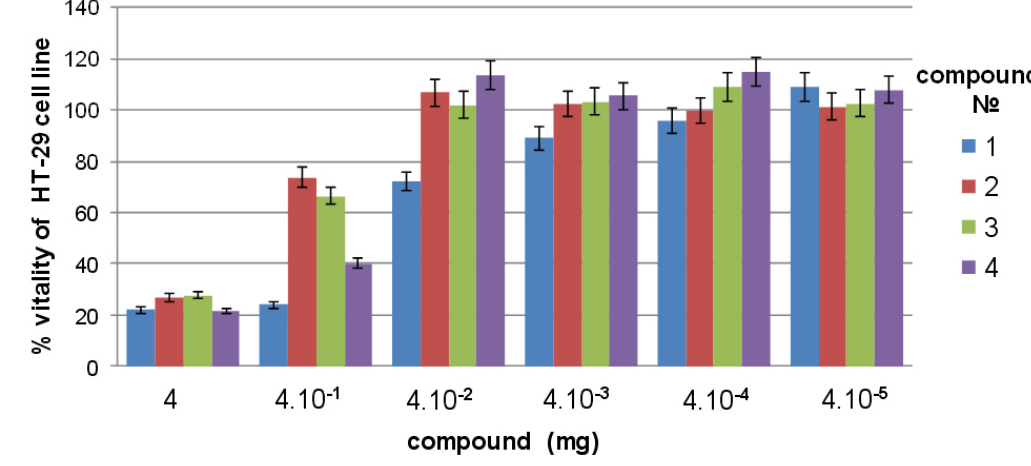
Figure 3. Vitality (%) of human epithelial colorectal carcinoma HT-29, treated with substances 1- 4 .